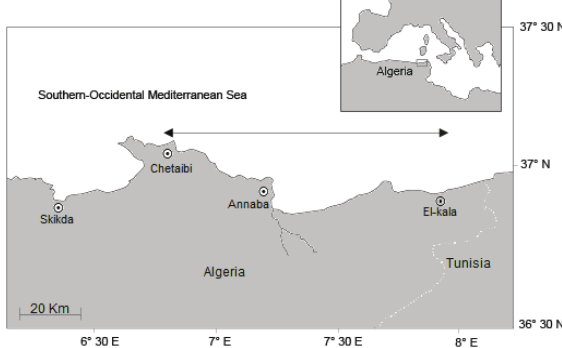
Fig. 1. The sampling range (↔) of peacock wrasse, Symphodus tinca , along the eastern coast of